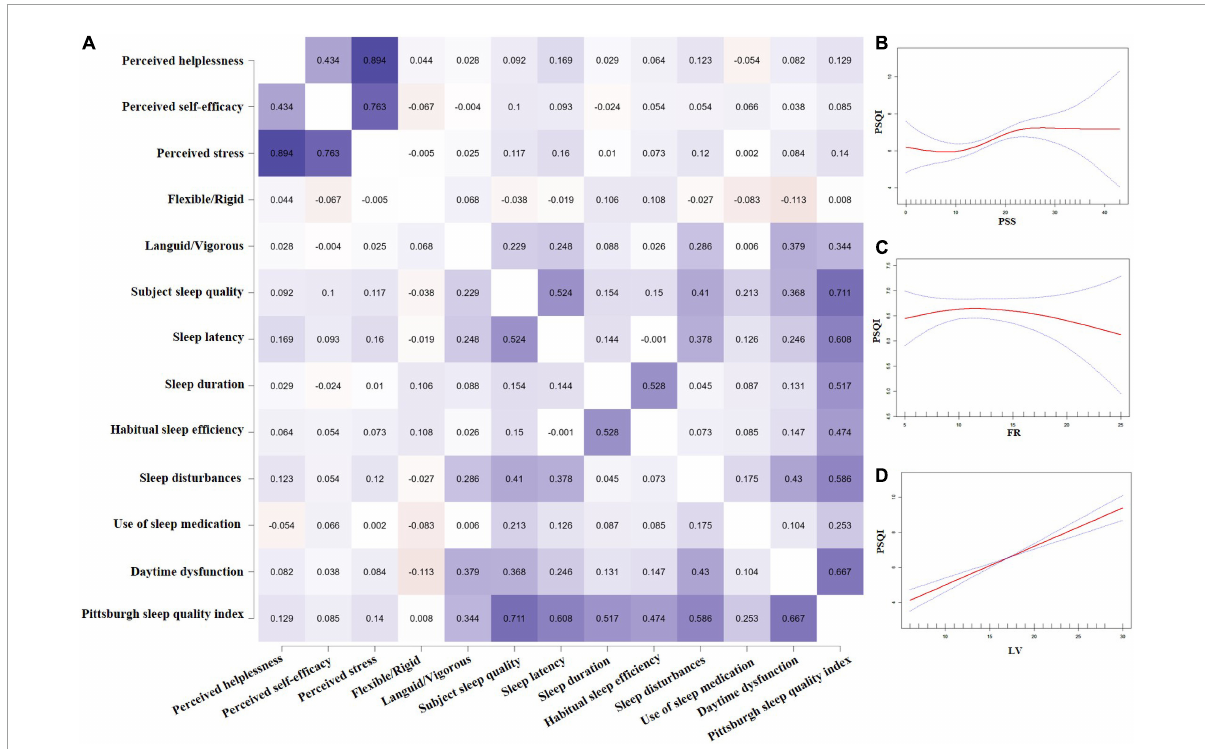
FIGURE2 Spearman correlation Heatmap among perceived stress, circadian rhythms, and sleep quality (A) , and curve line regression of the above three variables (B–D)